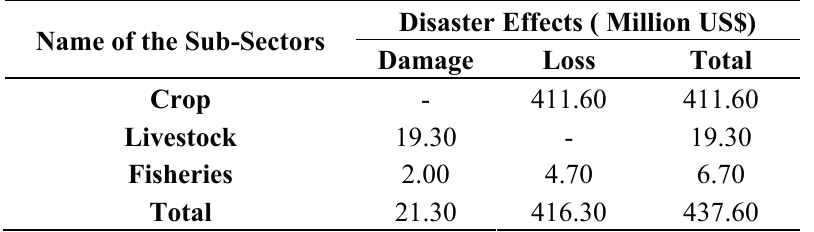
Table 1. Estimated damage and losses of agriculture during Cyclone Sidr in Bangladesh. Sources: Government of Bangladesh (GoB), 2008